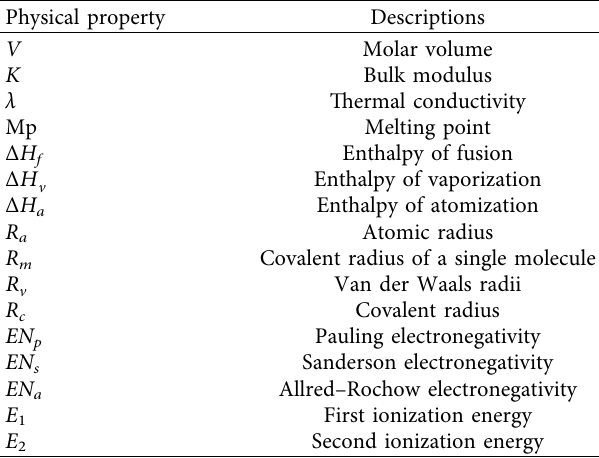
Table 2: Atomic and physical characteristics used in feature creation.